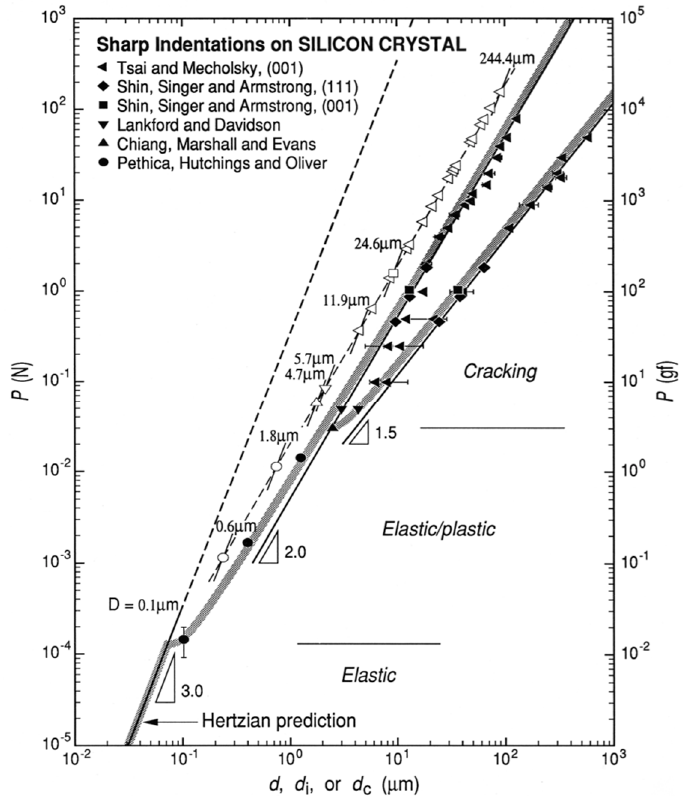
Figure 5. The load, P , versus elastic, d , plastic, d i , or crack extent, d c , dependence for cracking of silicon crystal surfaces indented with various sharp indenters [18].